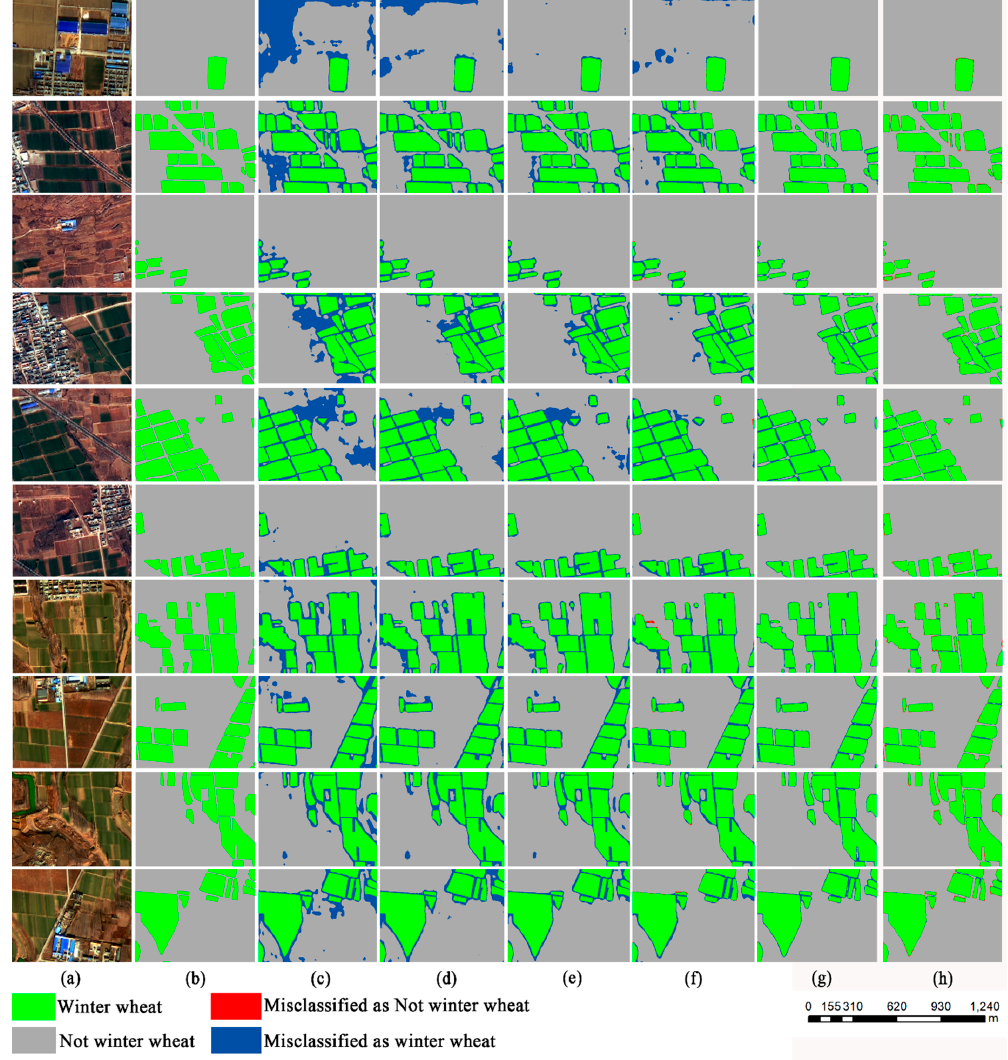
Figure 7. Comparison of the segmentation results for 10 randomly selected image blocks: ( a ) original images, ( b ) manually-labeled images corresponding to (a), ( c ) SegNet, ( d ) SegNet-CRF, ( e ) SegNet-PCCRF, ( f ) RefineNet, ( g ) RefineNet-CRF, and ( h ) RefineNet-PCCRF. CRF: Conditional random field, PCCRF: Partly connected conditional random field.